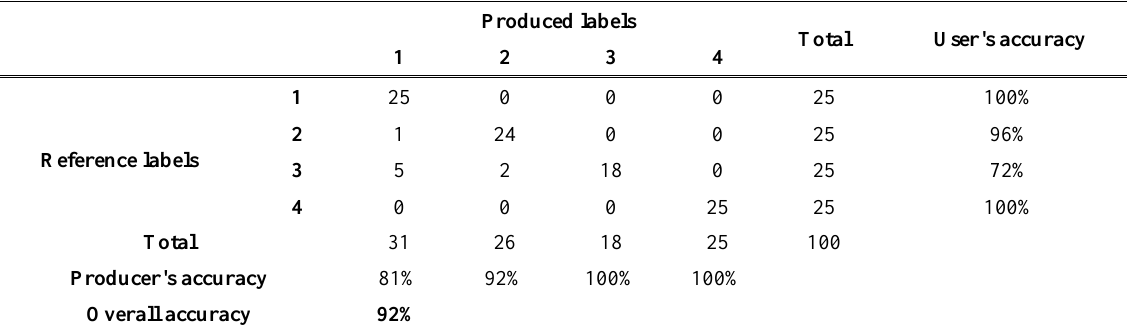
Table 4 . The error matrix used to report accuracy results in Genoa with land cover types indicated as follows: 1 = built-up, 2 = vegetation, 3 = barren land, 4 = water body.